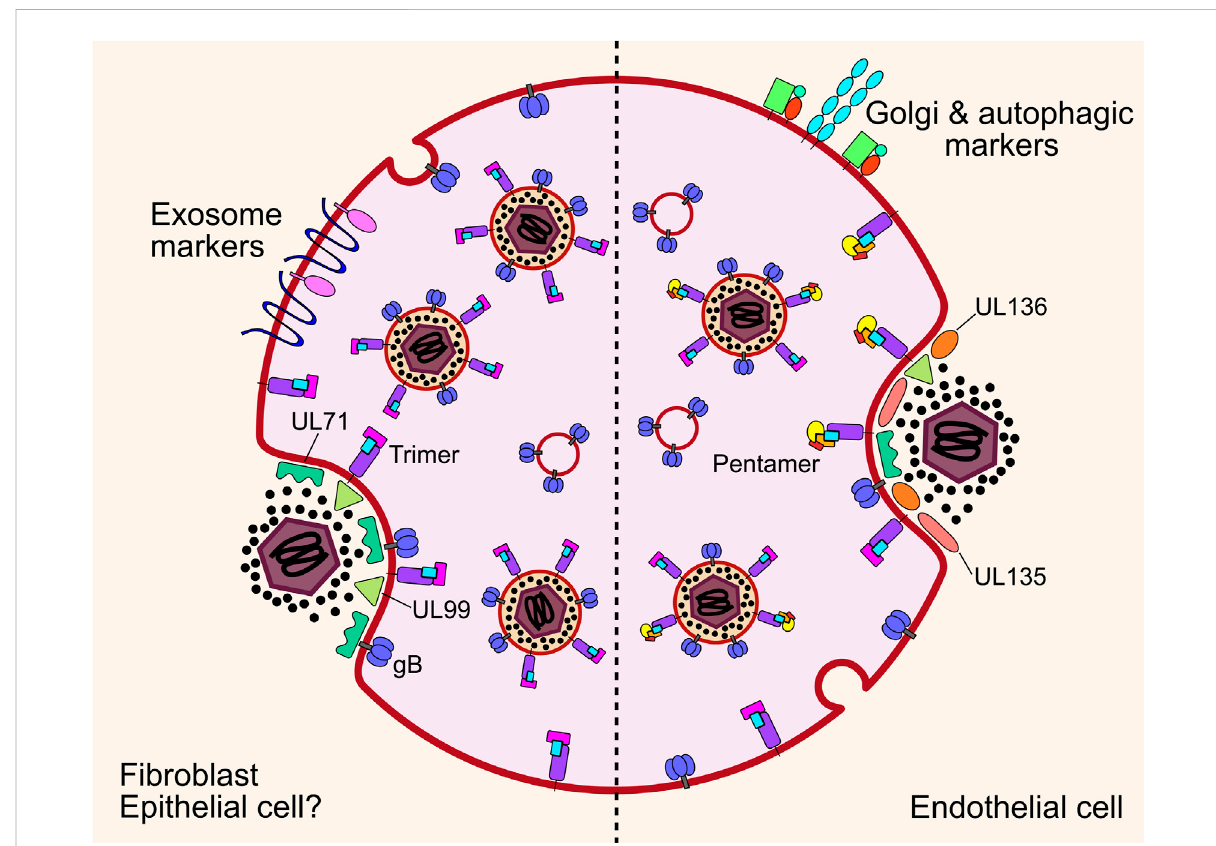
FIGURE 9 Cytoplasmic envelopment of nascent virions occurs on MVB membranes or short cisternae within the vAC. In fi broblasts and likely epithelial cells,envelopmentismediatedbymultipleenvelopeglycoproteinsandthemembraneassociatedtegumentproteinsUL71andUL99.Thesiteof fi nal envelopment as well as the virion envelope are enriched in exosome markers that indicates a common membrane origin. In endothelial cells, fi nal envelopment also occurs on MVB membranes. However, these are not enriched in exosome markers, but rather contain Golgi and autophagic markers. Additionally, the viral proteins UL135 and UL136 are important for envelopment in endothelial cells, but are entirely dispensable in fi broblasts.Note:UL71andUL99areincludedinthediagramforendothelialcellenvelopment,astheyarewellconservedinclinicalstrains.However, they have not been directly assayed in endothelial cells. MVB, multivesicular body; gB, envelope glycoprotein